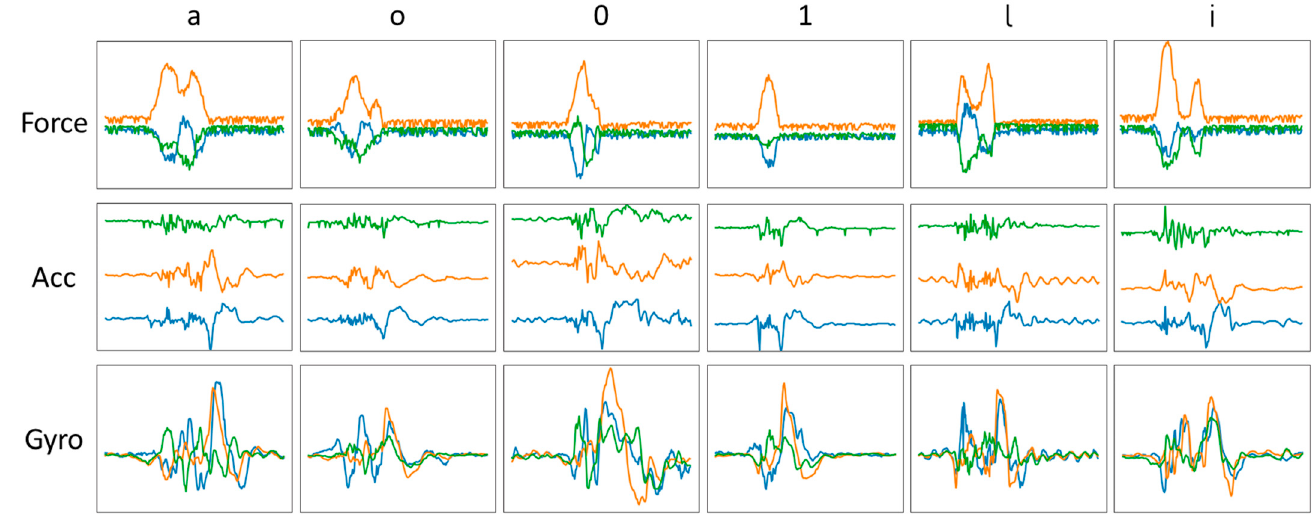
Figure 5. Raw dataset of lower-case letters: ‘a’, ‘o’, ‘l’, ‘i’ and numbers: ‘0’ and ‘1’.